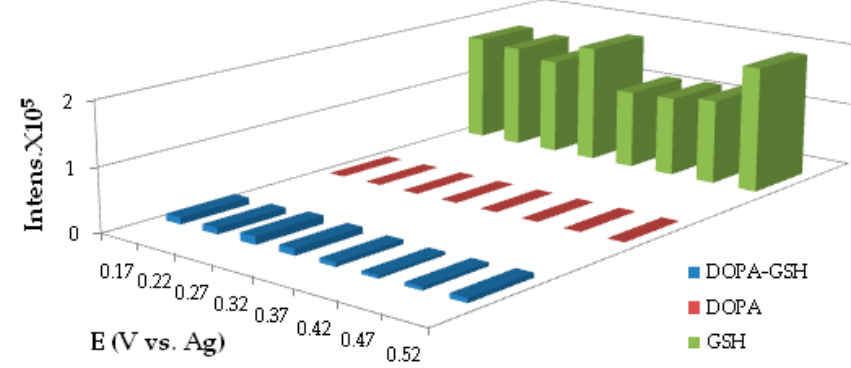
Figure 10. Potential optimization for DOPA electrochemical metabolism on a bare SPE.